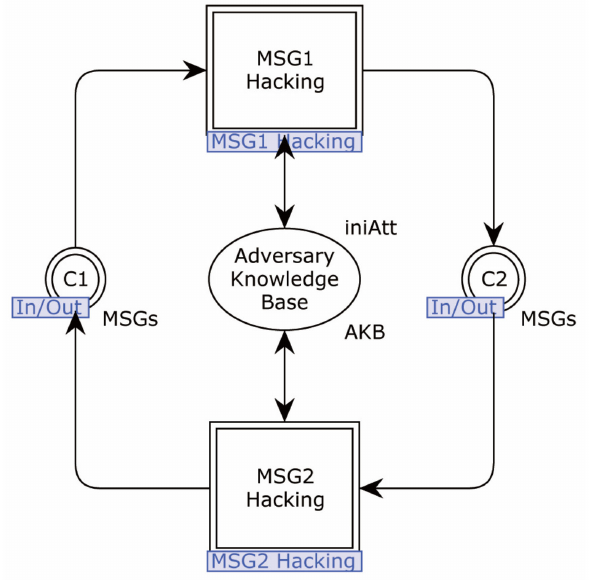
Figure 12. The second-layer page of the network (Adversary).